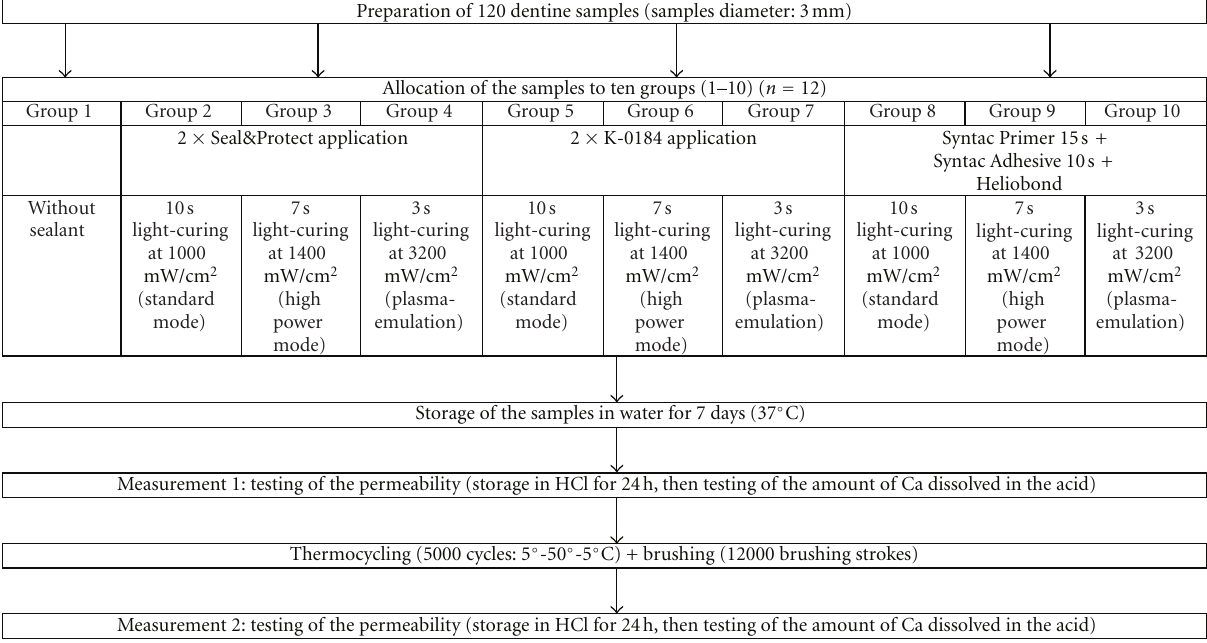
Figure 1: Sample allocation and experimental procedure. Table 1: Composition of the used surface sealants and adhesive system (manufacturer’s